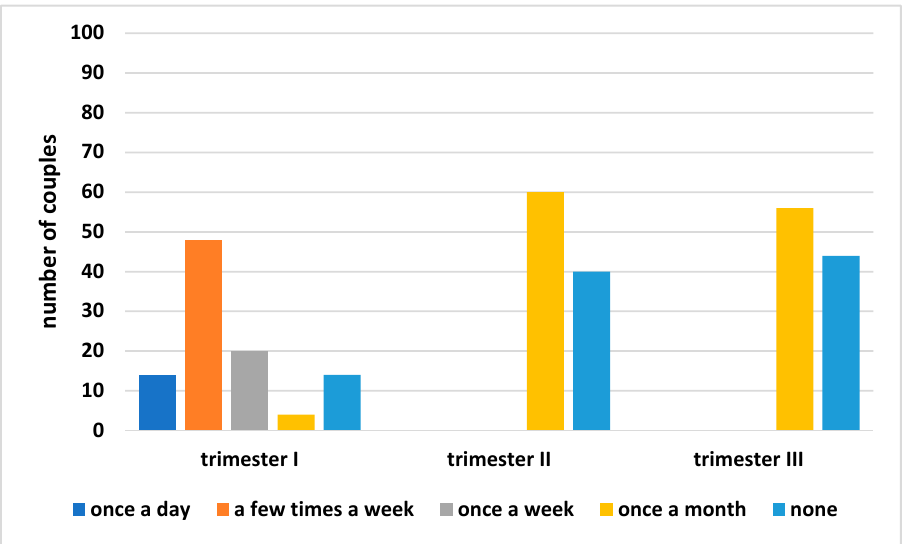
Figure 2. The frequency of sexual intercourse of the couples depending on the pregnancy tri- mester.